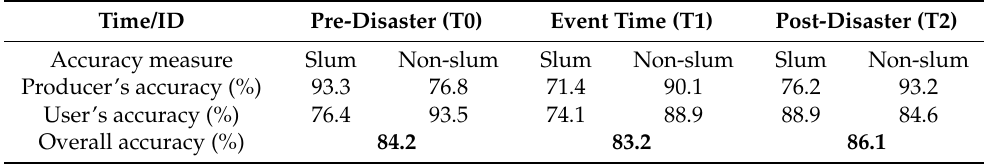
Table 2. Accuracy assessment results for slum detection for 8 months before (T0), 3 days after (T1), and 4 years after (T2) after Typhoon Haiyan.